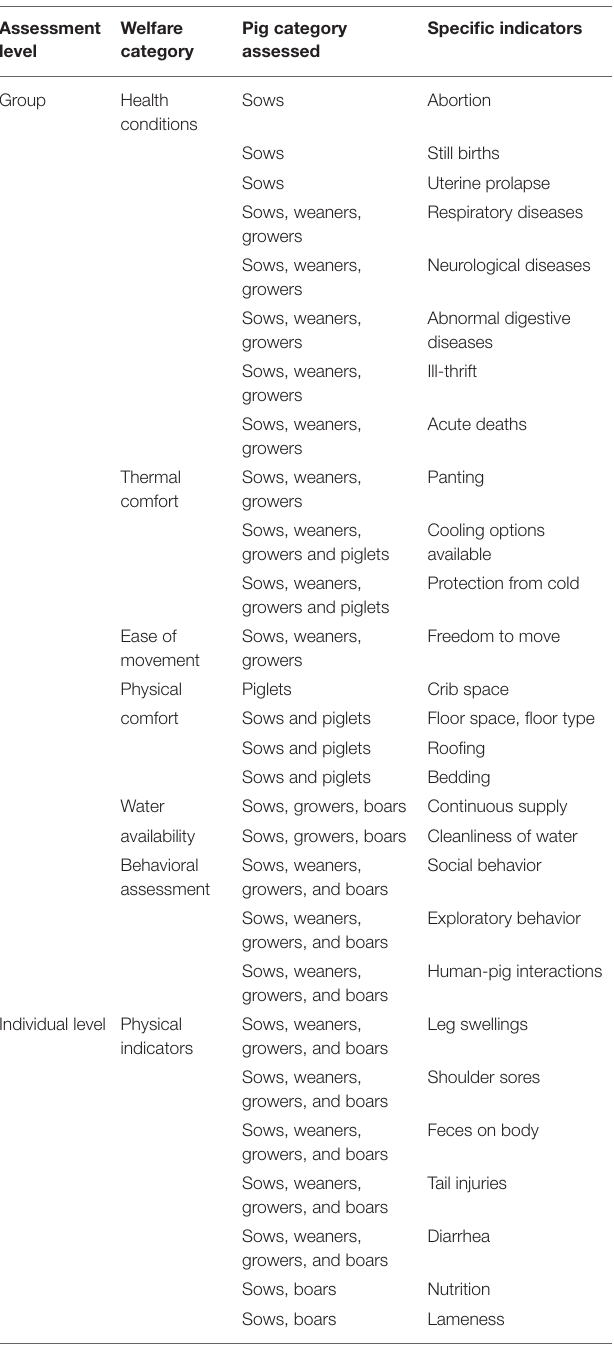
TABLE 1 | Welfare measures assessed in the study at individual and group levels. Assessment Welfare level